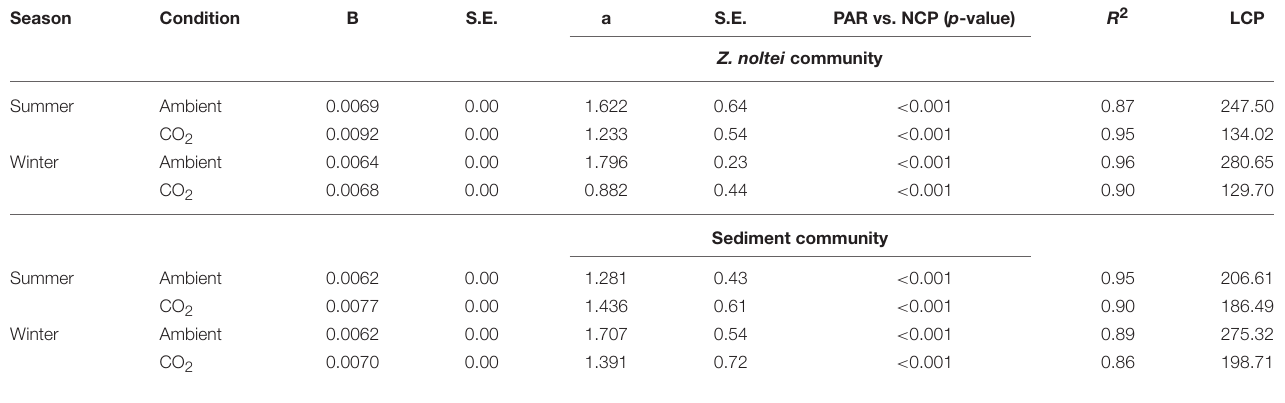
TABLE 2 | Slope (b), intercept (a), p, R 2 , standard error (S.E.) and light compensation point (LCP, µ mol m − 2 s − 1 ) values derived from linear regression model between PAR and NCP under ambient and CO 2 enriched conditions for Z. noltei community and unvegetated sediments